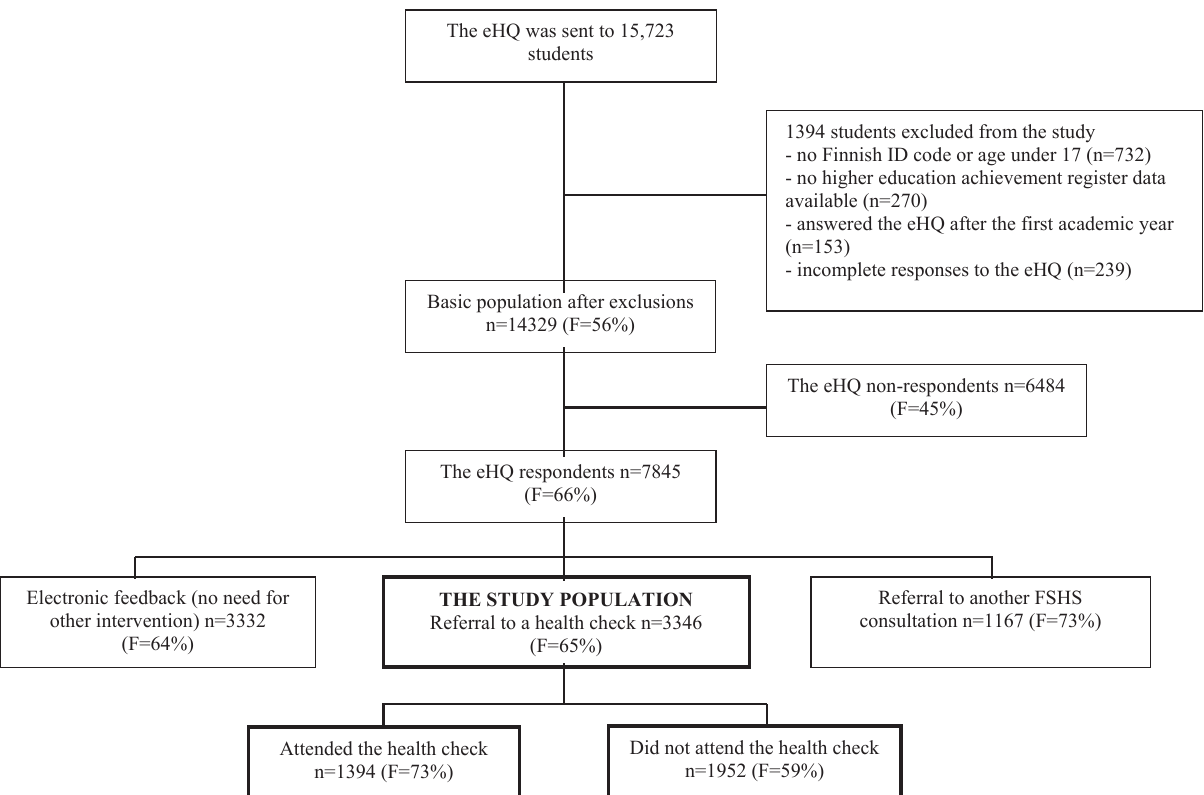
Fig. 1 Proportions of females (F) presented in parentheses for each step of the health examination